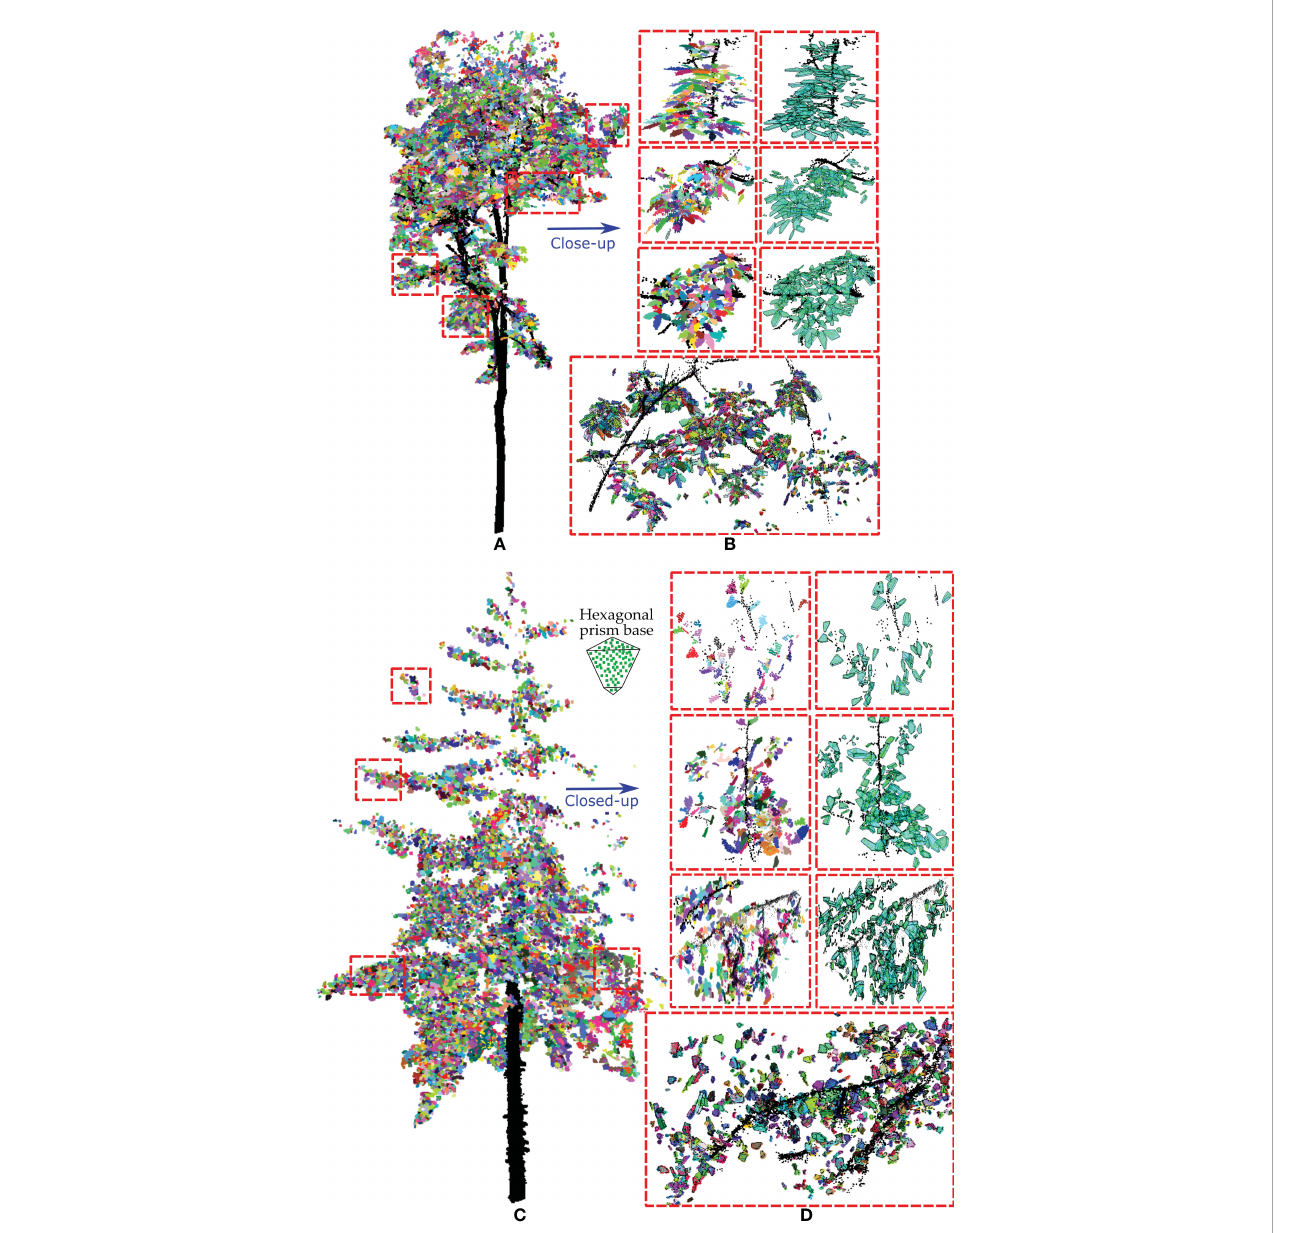
FIGURE 5 The experimental results of our method applied to the two taller trees. (A, C) show the leaf separation results for a rubber tree and a ginkgo tree, respectively, with the segmented individual leaves highlighted in different colours. (B, D) Close-up of four local areas in each tree crown displaying the extracted individual leaf points and the corresponding enclosed hexagonal prisms, separately or